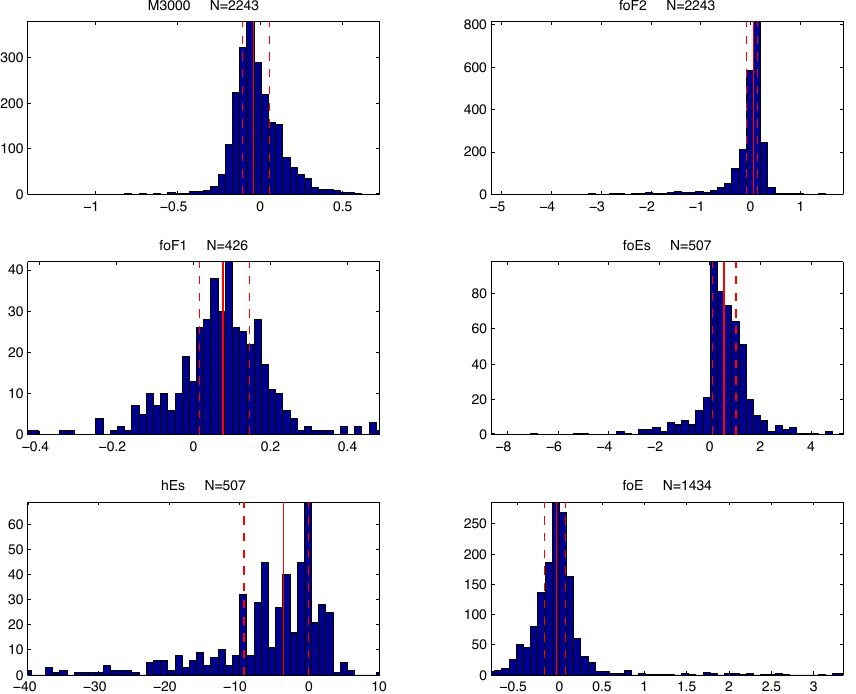
Figure 4. Distributions (histograms) of the differences between manually and automatically scaled parameters. Numbers ( N ) on top of the panels indicate the numbers of ionograms for which both manual and Autoscala parameter values were obtained, and, hence, the differences were calculated. Vertical lines show medians and quartiles. Table 3. Scaled parameters of sporadic E